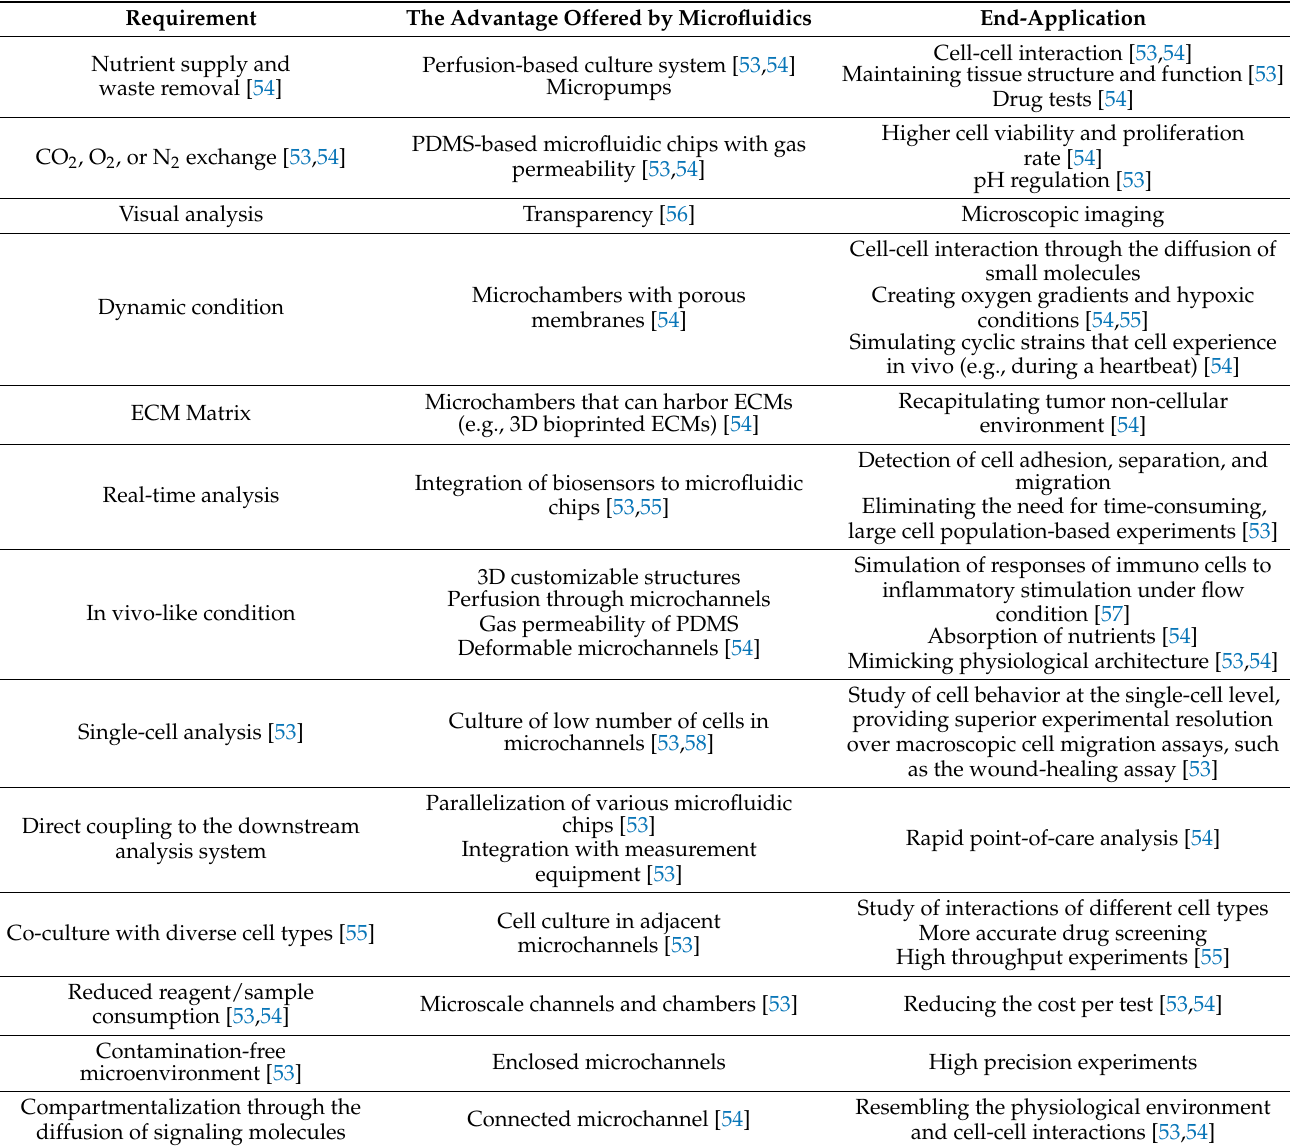
Table 1. Requirements of glioma-on-chip platforms and the possible contribution of microfluidic chips [53–58].